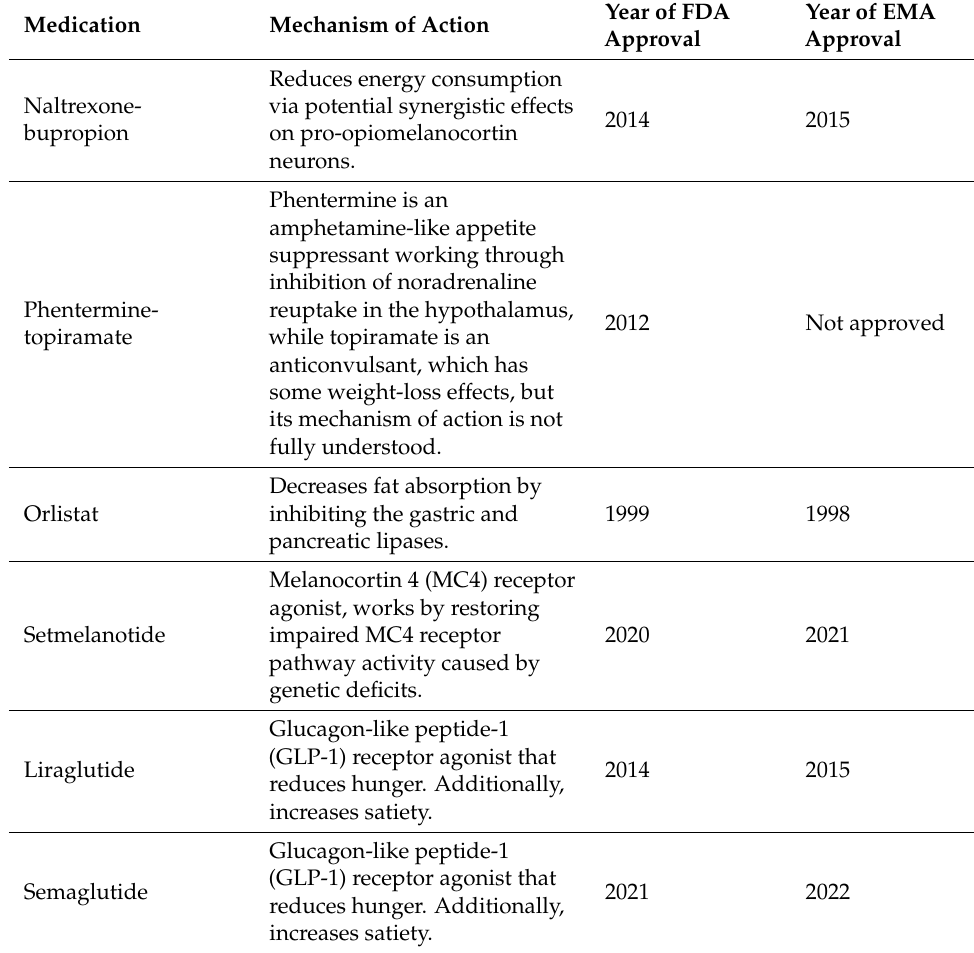
Table 1. Mechanism of action and approval status of main obesity medications